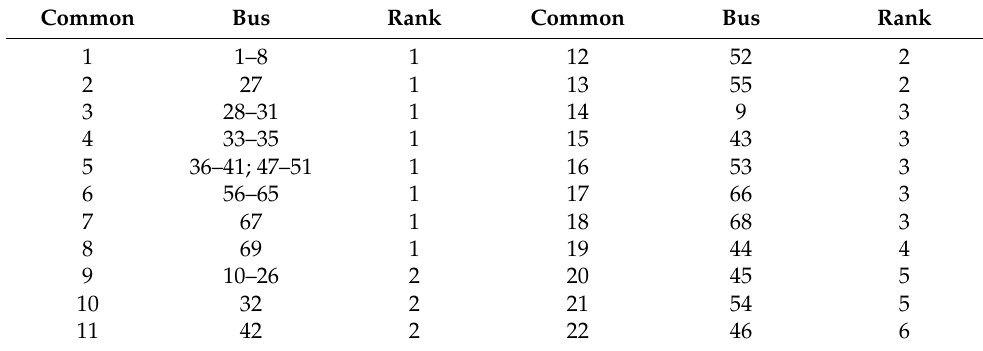
Table 3. List of commons and ranks in the test system.